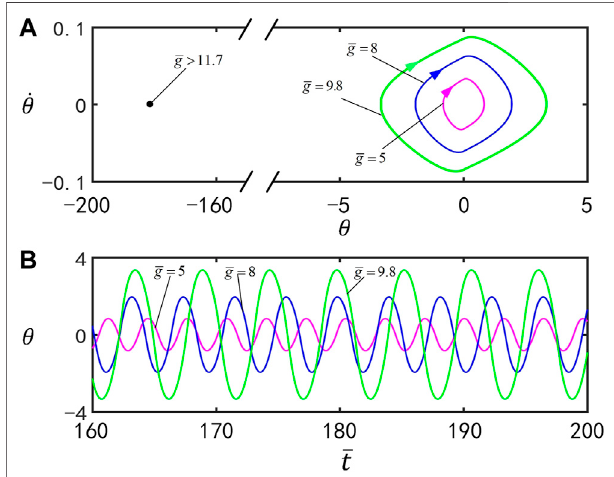
FIGURE 9 | Effect of the gravitational acceleration (cid:2) g on self-stabilized oscillation of the inverted pendulum for (cid:2) I (cid:2) 0 . 25, C 0 (cid:2) 0 . 4, (cid:2) ζ (cid:2) 14 . 7, θ 0 (cid:2) 0 ° , θ (cid:2) 70 ° , and _ θ (cid:2) 0. (A) Limit cycles for (cid:2) g (cid:2) 5, (cid:2) g (cid:2) 8, and (cid:2) g (cid:2) 9 . 8. (B) Time 1 0 series for (cid:2) g (cid:2) 5, (cid:2) g (cid:2) 8, and (cid:2) g (cid:2) 9 . 8. The amplitude and period of self- stabilized oscillation increase by increasing (cid:2) g